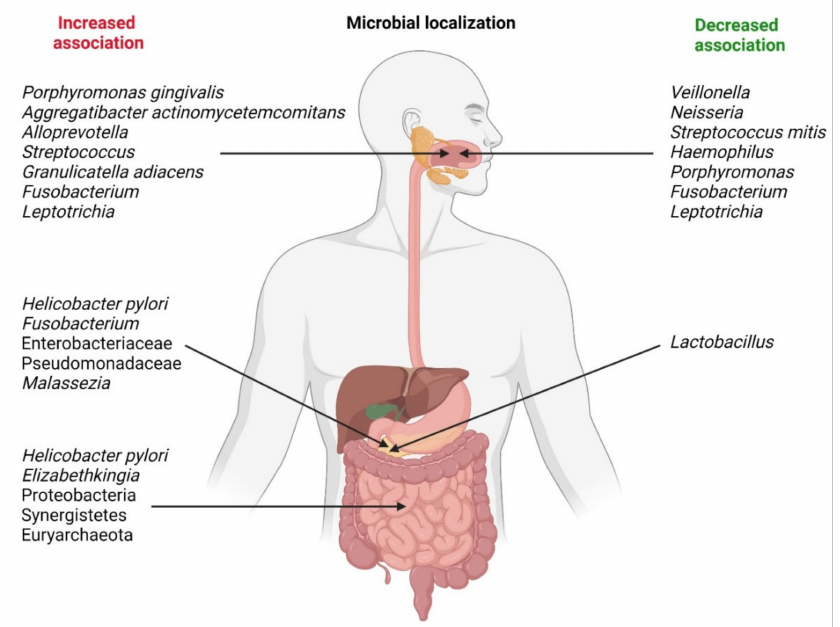
Figure 1. Microbial localization and changes in bacterial associations related with pancreatic carcinogenesis.